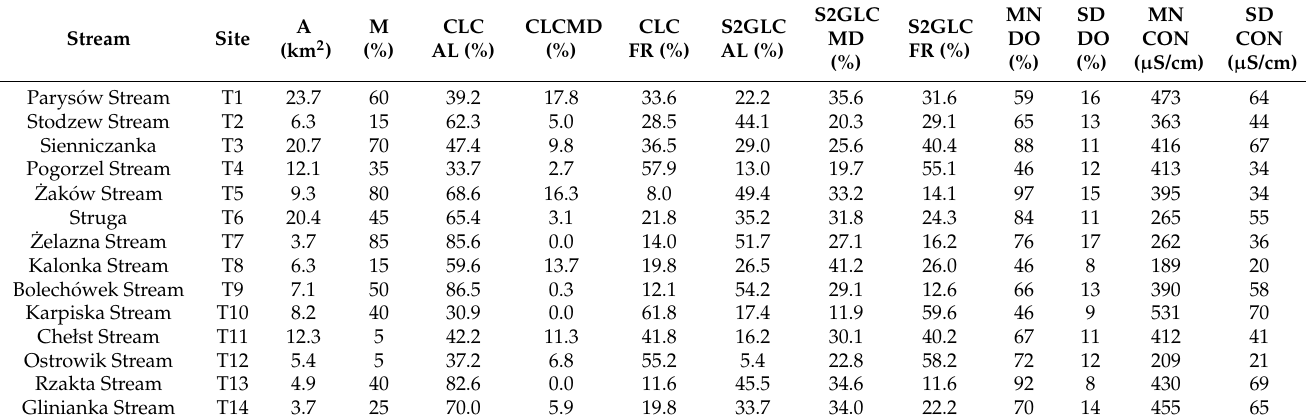
Table 2. Detailed characteristics of the sampling sites